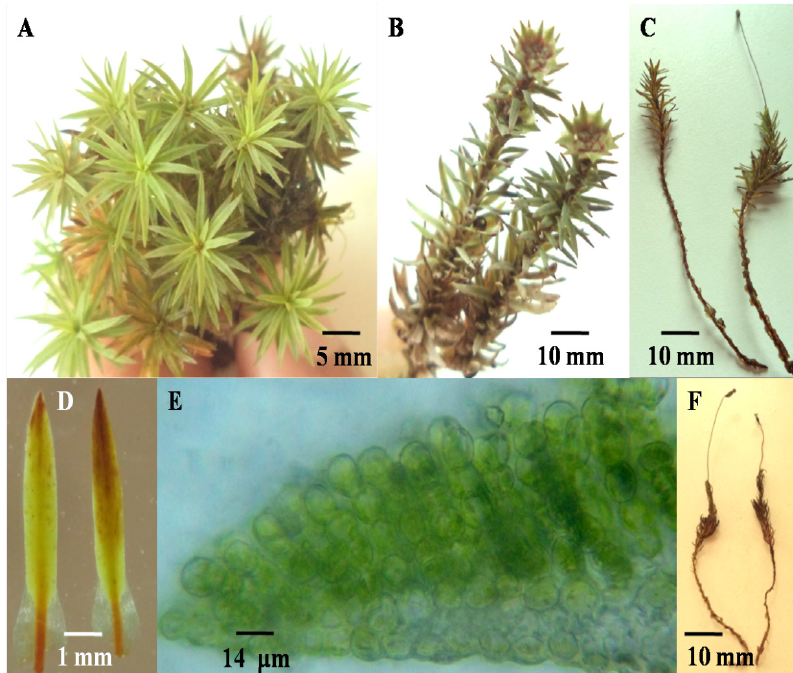
Figure 11: Pogonatum urnigerum (Hedw.) P. Beauv. (A) fresh habit (B) male gametophyte with perigonia (C) female gametophytes with sporophytes (D) vegetative leaves (E) part of a transverse section of leaf with the margin (F) dry female